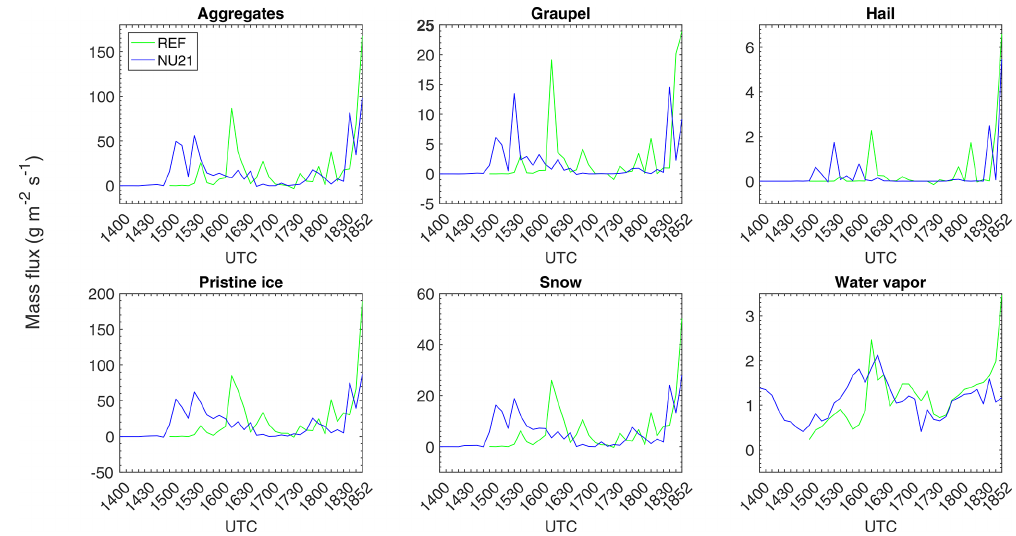
Figure 7. The instantaneous domain-average mass-flux rate (gm − 2 s − 1 ) of each hydrometeor and water vapour is illustrated in the third grid of the simulations for REF (green) and NU21 (blue). The cosine component of the vertical velocity with respect to the horizontal is used to determine the upward flux rate, which takes into account the slope at the 380K level due to deep